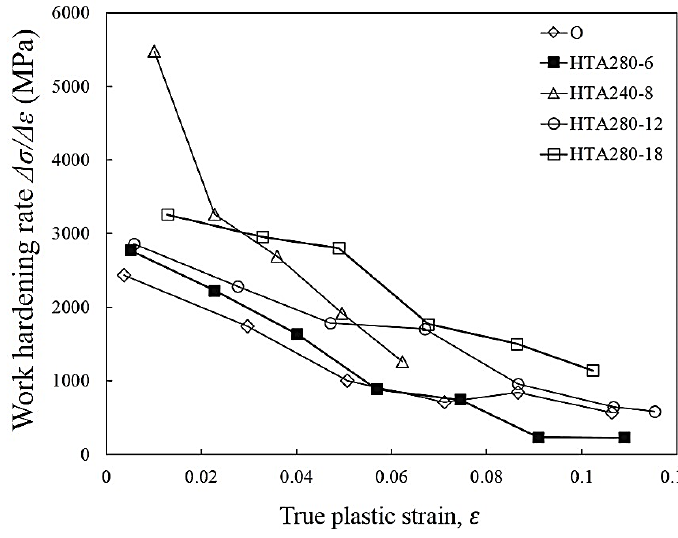
Figure 13. Work hardening curves of 7075 Al alloy extruded rod with various PPHTs.